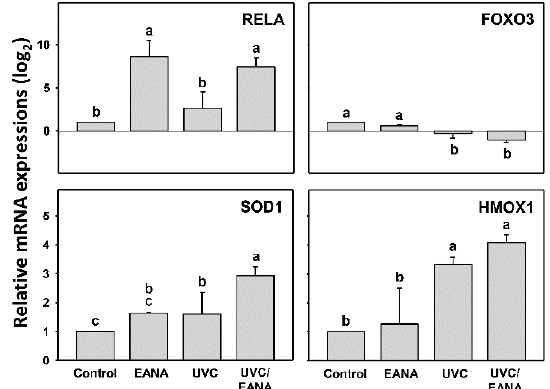
Figure 7. Antioxidant gene expressions of EANA and / or UV treatments for human oral cancer Ca9-22 cells. Cells were treated with control (DMSO only), EANA (5 µ g / mL), UVC (12 J / m 2 ), and combined treatment (UVC / EANA) for 24 h. Antioxidant mRNA gene expressions such as RELA , FOXO3 , SOD1 , and HMOX1 were tested by qRT-PCR analysis. Treatments showing no overlapped labels (a–c) di ff er significantly between multiple comparisons ( p < 0.05–0.0001). Data, mean ± SD ( n = 3).